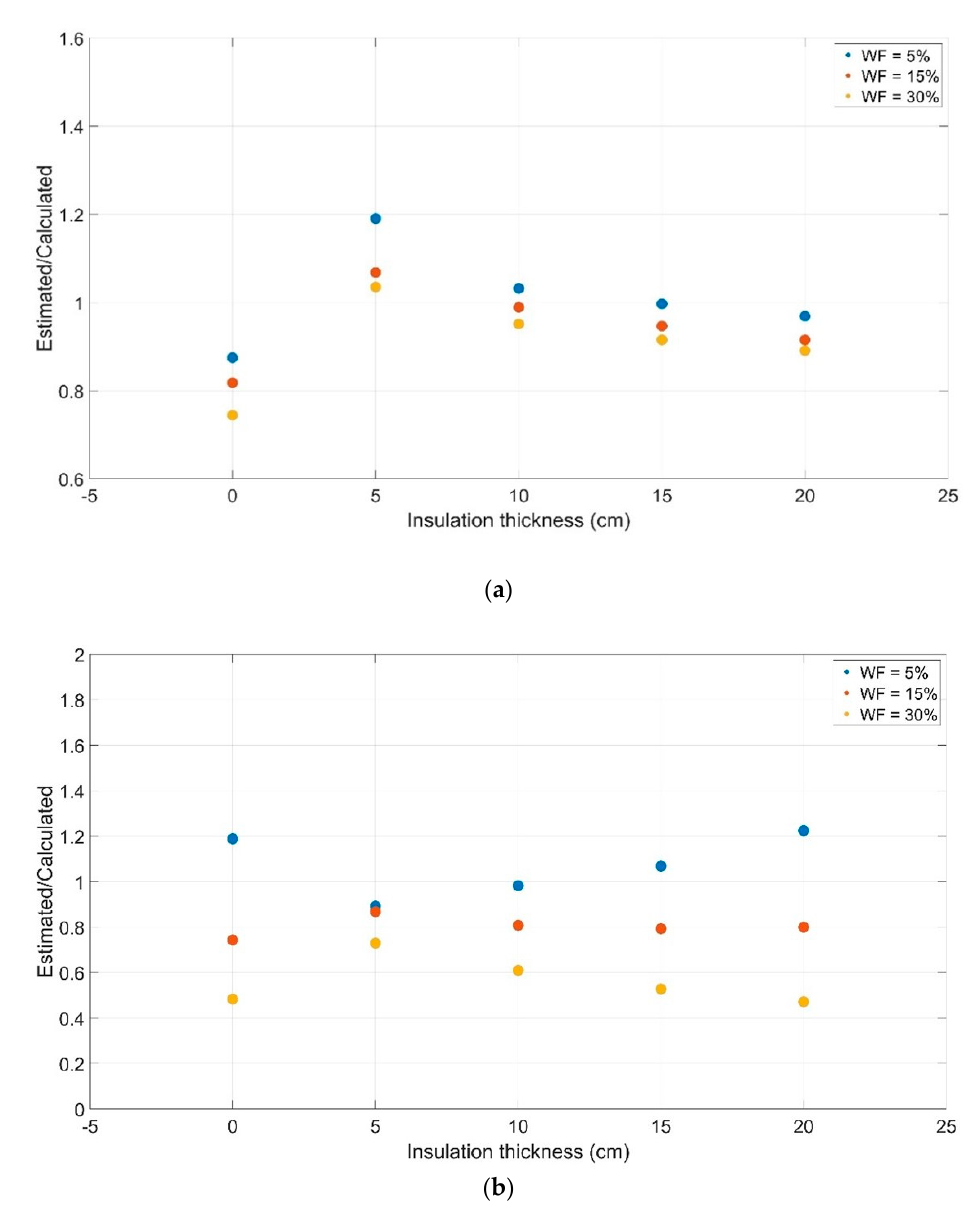
Figure 13. Estimated/calculated ratio of thermal resistances for various WF values and insulation layer thicknesses for heavy-structured buildings: ( a ) building envelope; ( b ) floor.